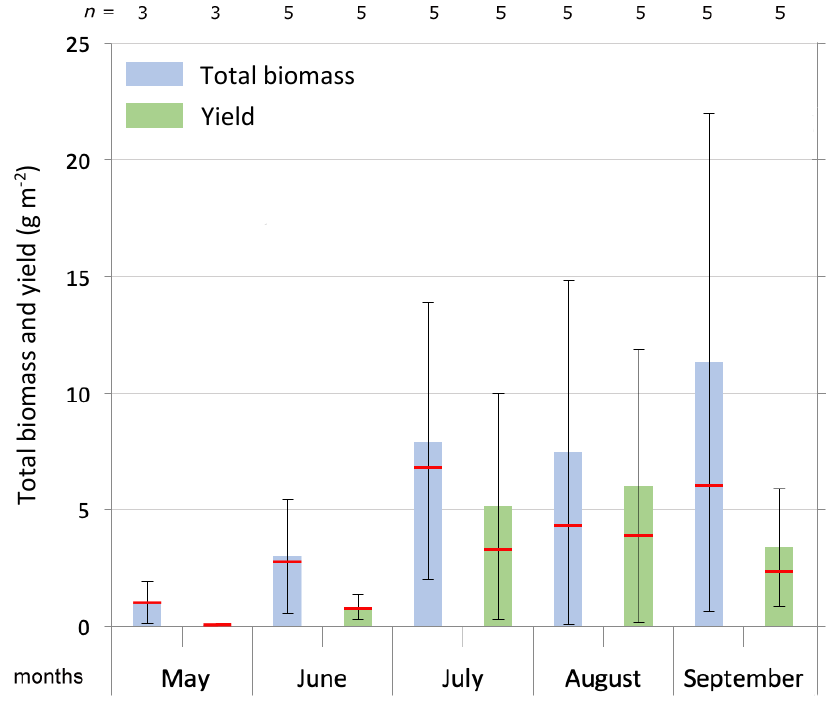
Figure 5. Total biomass (all flowering/non-flowering plants in the plots) and yield (all flowering plants) of Drosera intermedia on the Sphagnum papillosum field between May/June and September in 2013 and 2014. Vertical bars show the means, the whiskers the standard deviations, the red lines the medians. Number of replicates ( n ) is written above each